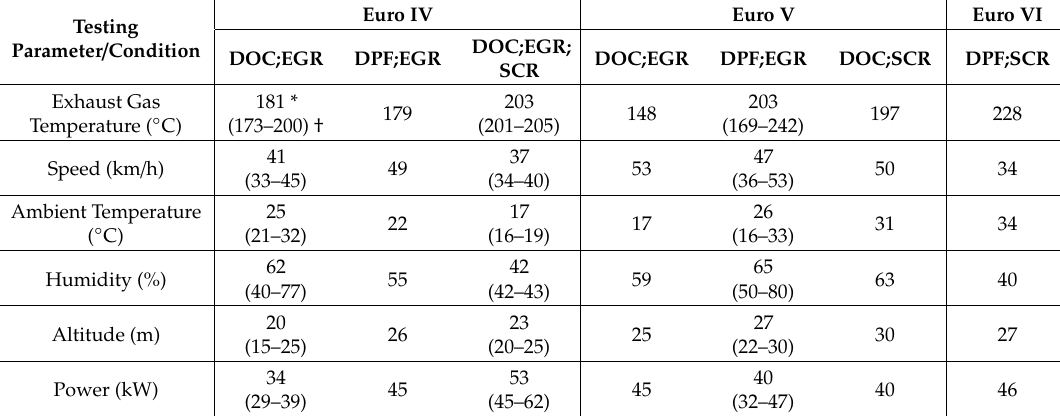
Table 2. Testing conditions per vehicle category.